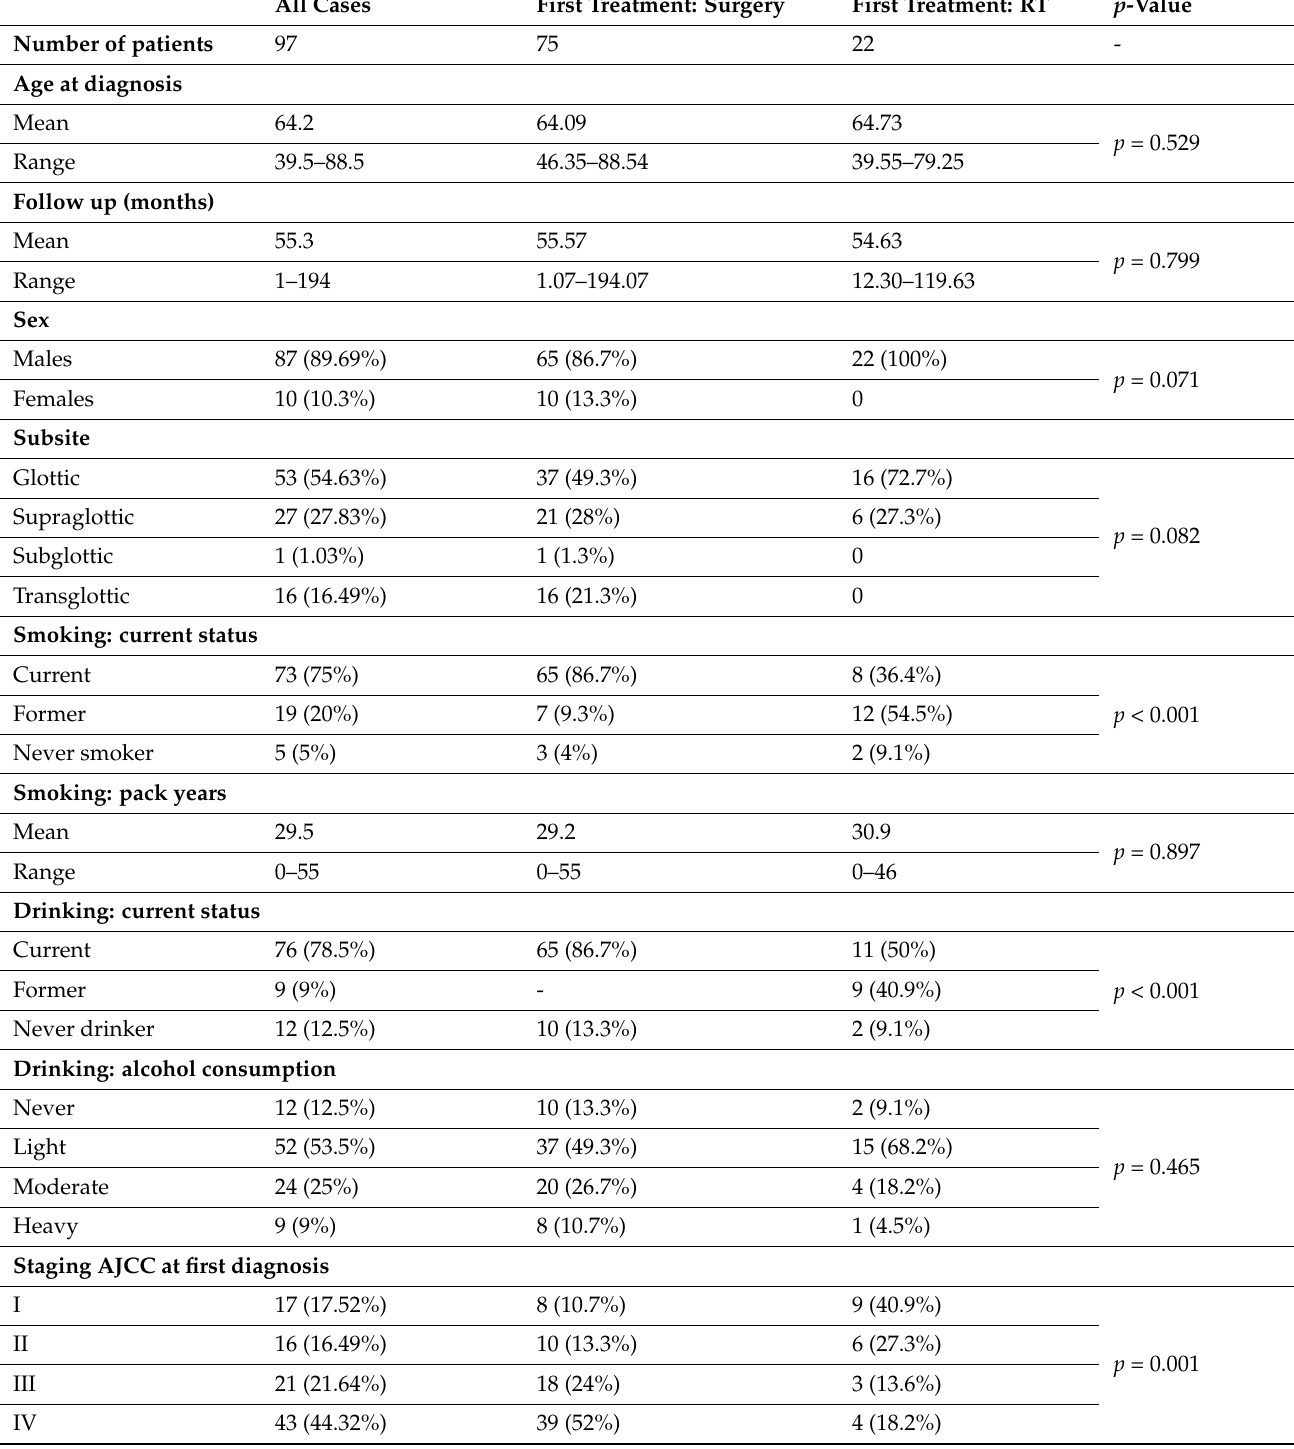
Table 1. Personal and clinicopathological data of the patients, stratified in primary and salvage surgeries. Groups were compared by means of Mann-Whitney U test and chi-square